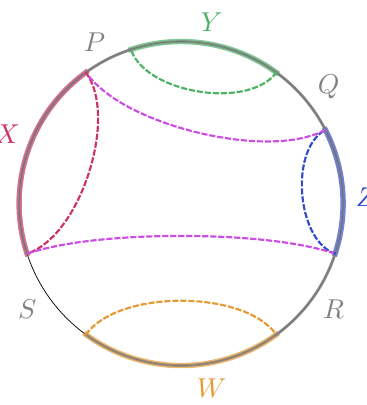
Figure 8 . Generalization of (cid:12)gure 1 to allow our basic subsystems A , B , C and D to consists of arbitrarily many intervals, where we focus the potentially intersecting thread bundles for some 4 intervals X , Y , Z , and W picked out of the basic set, separated by the remaining intervals, collected into P; Q; R , and S